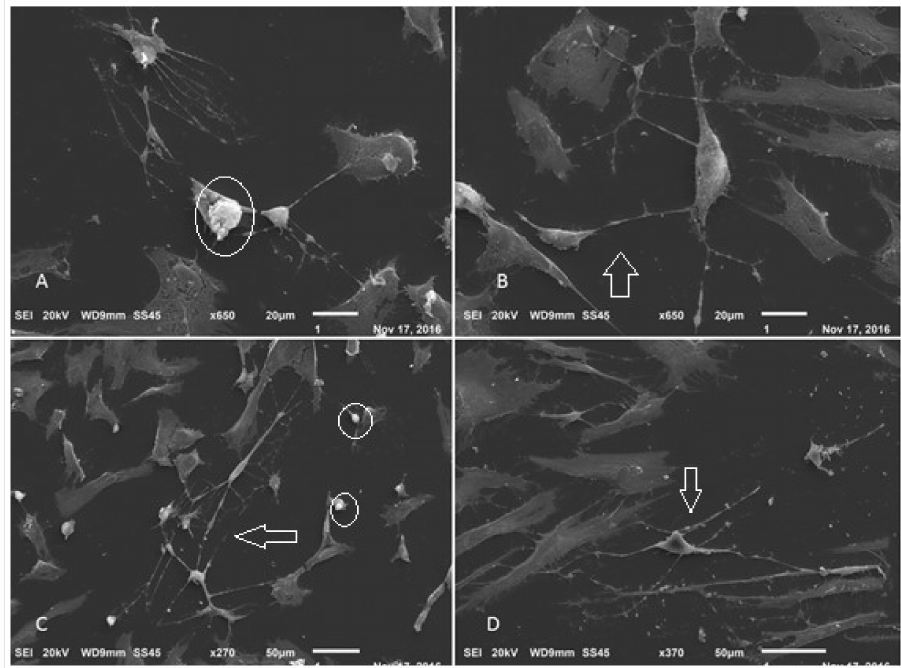
Figure 23. Scanning electron microscopy of Schwann cell differentiation. ( A – D ) Arrows point to cells with neural features. Circled details—exocytosis process (Jeol JFM—6010,